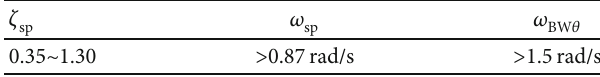
Table 1: Flying quality boundaries [23].